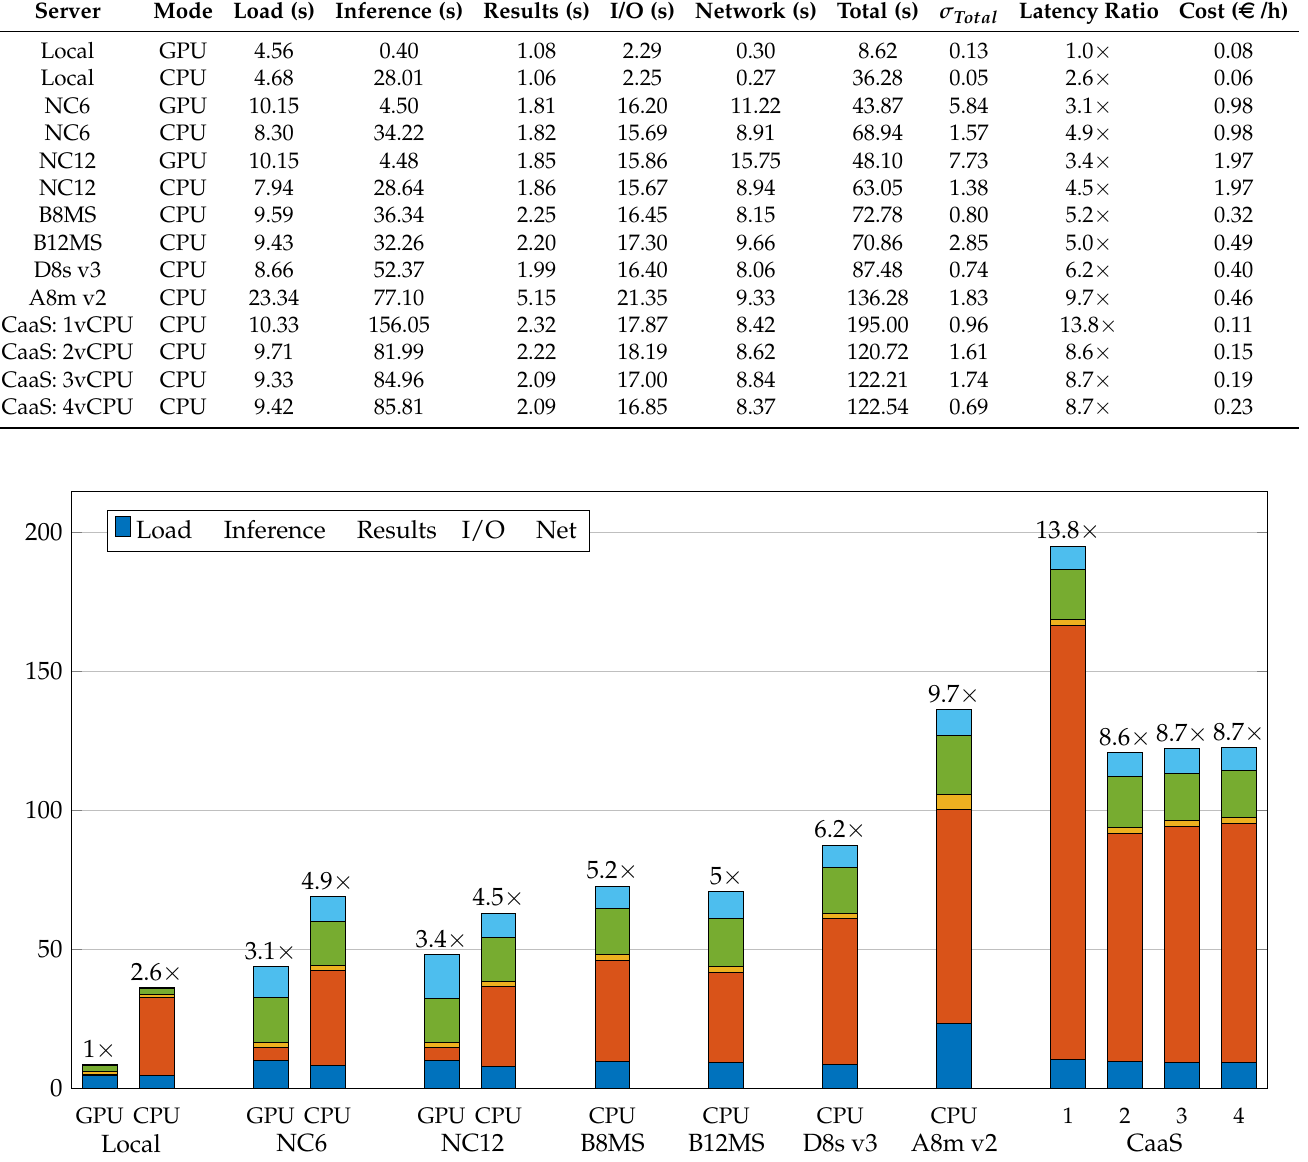
Figure 11. Comparison of performance offered by different infrastructures using a 10,000 × 10,000 images. Lower values are